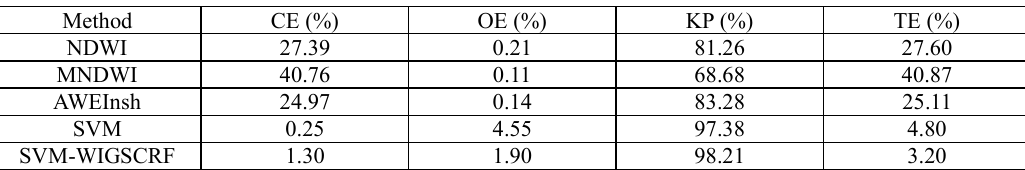
Table 2. Summary of accuracies for the proposed method over the study